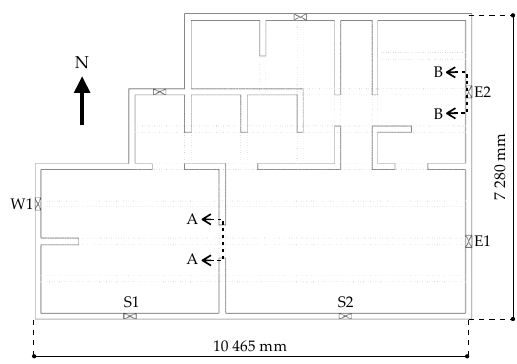
Figure 7. Inside of the underfloor ventilation area.